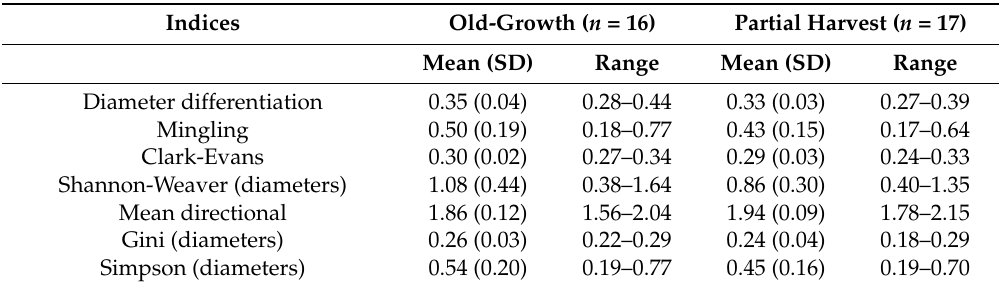
Table 4. Mean (standard deviation) and range of structural indices for old-growth and partially harvested stands. ( n = number of